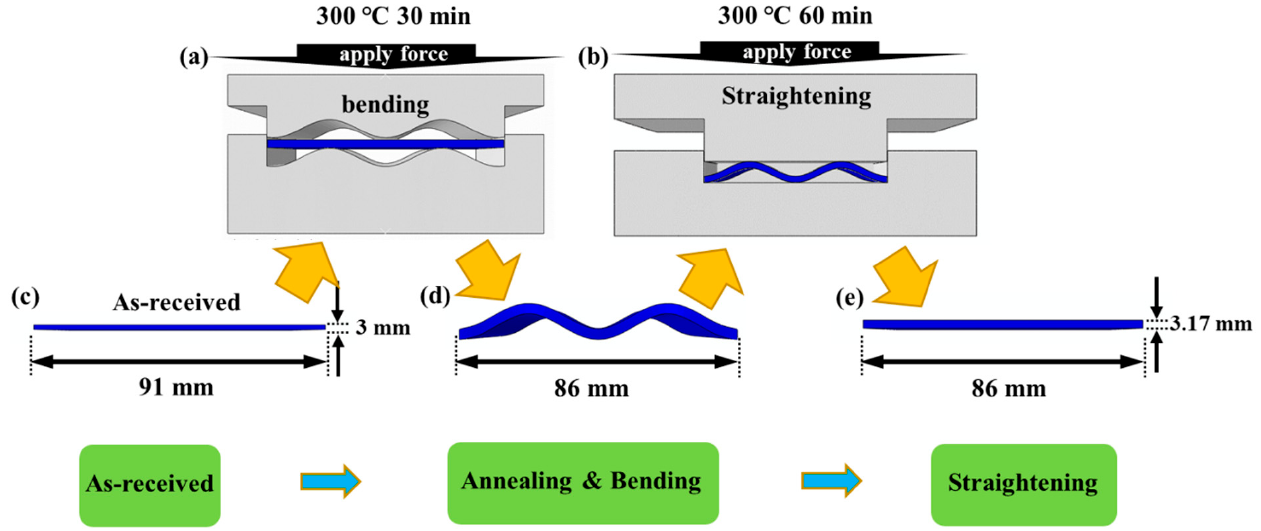
Figure 1. Bending and straightening process: ( a ) bending mold, ( b ) straightening mold, and ( c – e ) morphology of the plate at different stages of bending and straightening.